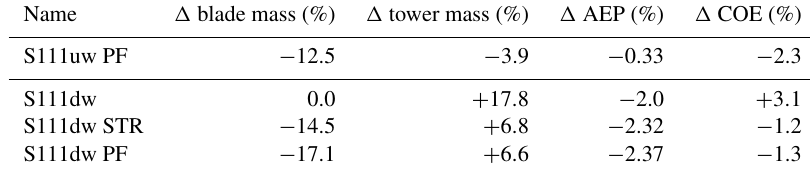
Table 4. Blade mass, tower mass, CAPEX, AEP, and COE differences for the regarded turbine configurations relative to the S111uw design. Name (cid:49) blade mass (%) (cid:49) tower mass